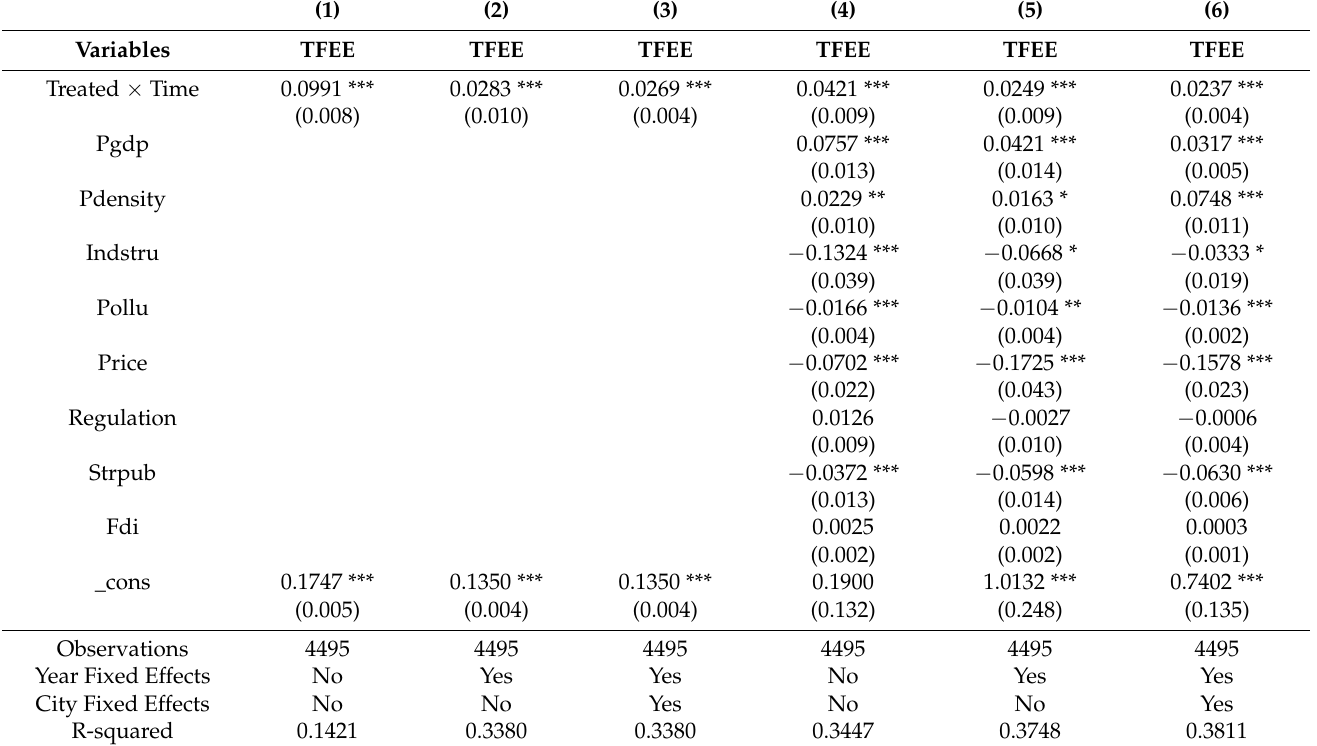
Table 2. Baseline regression result based on difference-in-differences (DID)